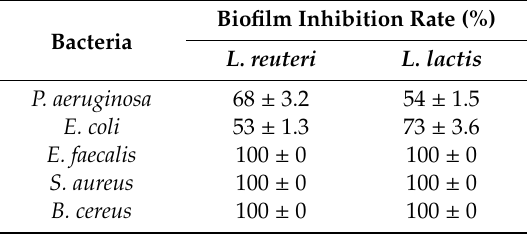
Table 4. Biofilm inhibitory properties of Lactobacillus strains against bacterial strains.